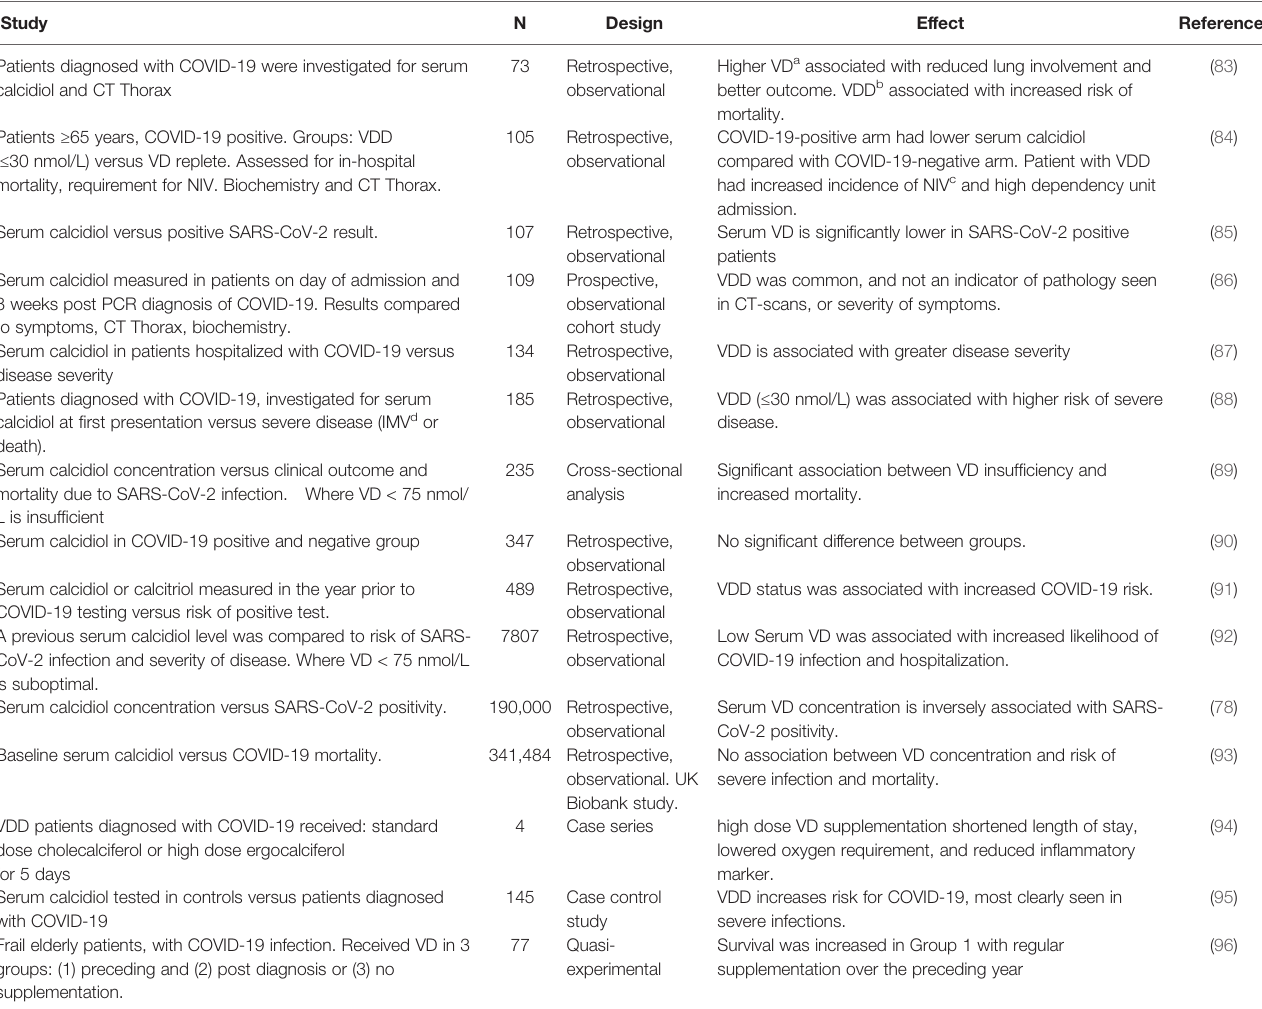
TABLE 1 | Observational studies, linking vitamin D status with outcome (severity of disease and mortality) in patients with COVID-19. Study N Patients diagnosed with COVID-19 were investigated for serum calcidiol and CT Thorax